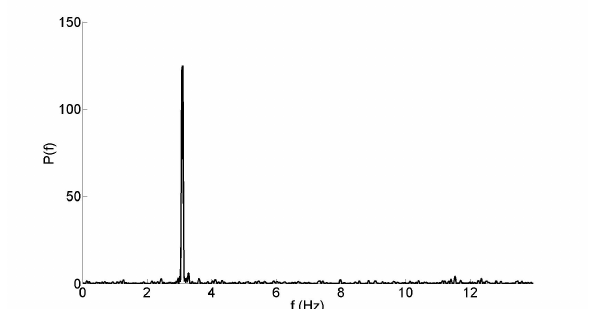
Figure 5. Power spectral density of thin plate centroid trajectory with 30 Hz from RC measurement